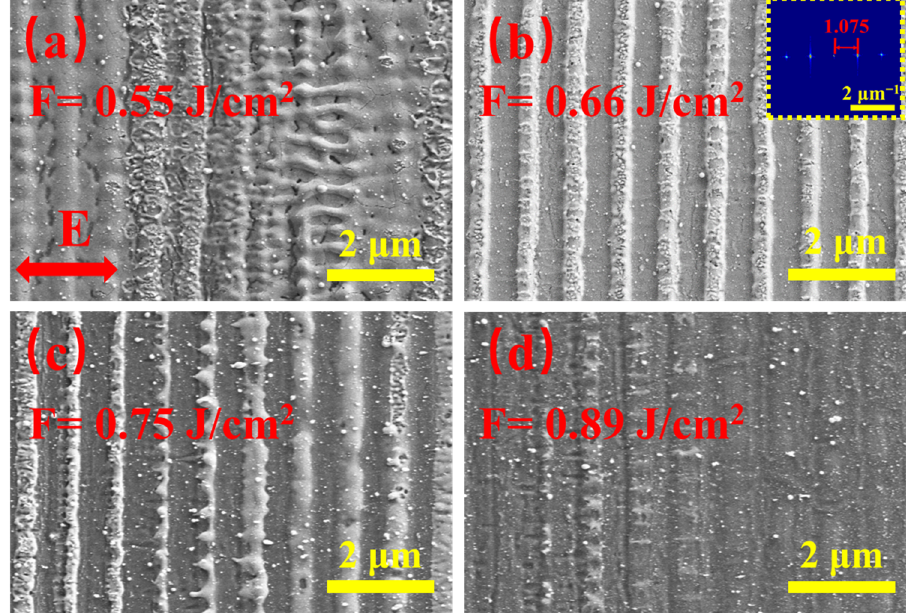
Figure 10. SEM images of LSFLa on the ITO film after laser irradiation under pulse fluences of ( a ) 0.55, ( b ) 0.66, ( c ) 0.75 and ( d ) 0.89 J/cm 2 with a fixed scanning velocity of 3 mm/s. The scale bars are all 2 µm. The FT image of ( b ) is highlighted in the inset. The double arrow in ( a ) indicates the laser polarization direction.